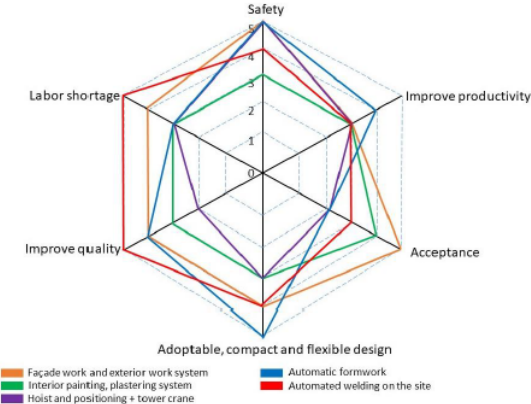
Figure 11. Spider chart of influential performance [147].